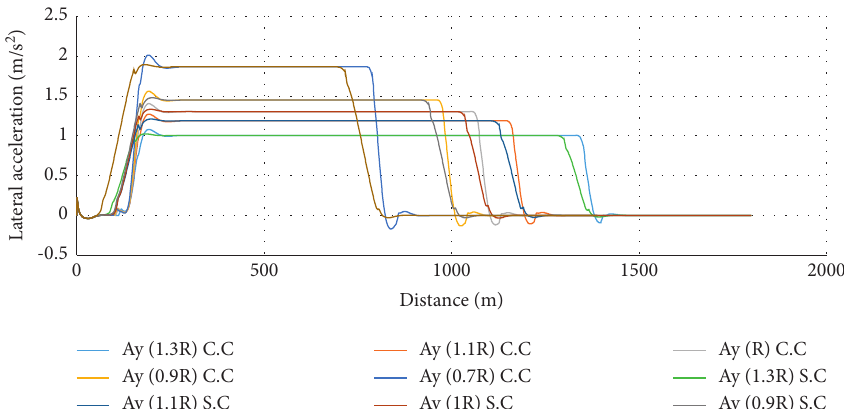
Figure 8: Lateral acceleration of simple and spiral horizontal curves versus path length for various radii for a sedan; C.C is the simple horizontal curve, and S.C is the spiral horizontal curve.